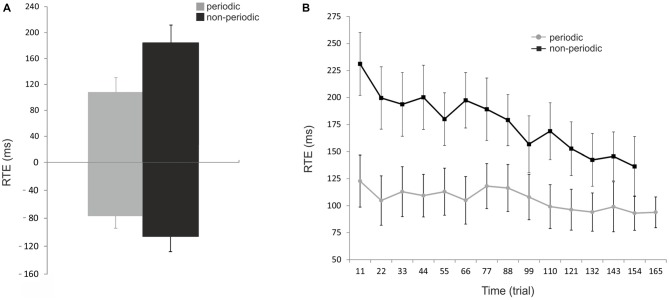
Behavioral results. (A) Effect of periodicity of motion on performance. Reaction time error (RTE) represents the accuracy of the subject in estimating the pendulum interception instant; RTEs with positive and negative values correspond to over- and underestimation of the pendulum ToA, respectively. The mean RTE (± SEM) to periodic trials (gray bars) were significantly shorter than that to non-periodic trials (black bars) for both positive and negative values. (B) Effect of trial number on performance. Mean RTE (± SEM) as absolute numbers and averaged for every 11 trials across all subjects for both conditions (periodic: gray line; non-periodic: black line). The interception timing becomes significantly more accurate over time in both conditions but with a stronger effect of trial repetition in the non-periodic condition. Periodic: [F(8.44,92.82) = 4.35, p < 0.005]; Non-periodic: [F(8.77,96.47) = 4.54, p < 0.0001]; Interaction time * condition: [F(8.21,90.26) = 3.15, p = 0.003].